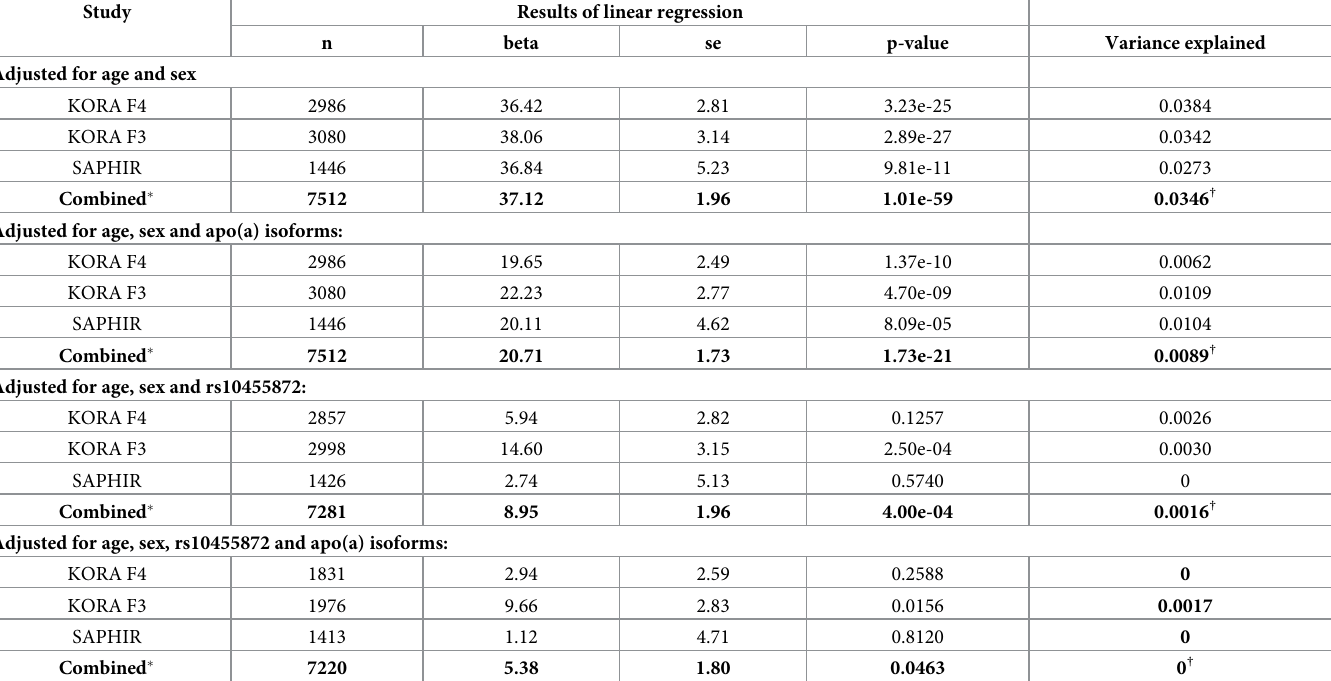
Table 2. Association analysis of rs76735376 on Lp(a)